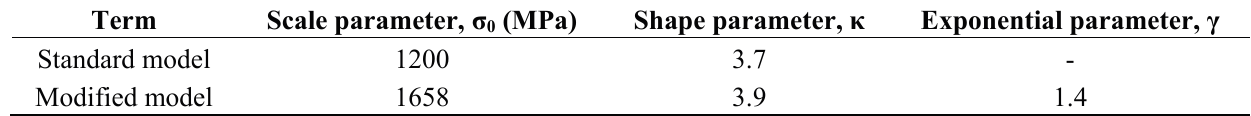
Table 3. Weak-link Weibull estimates for tensile strength in the fiber length direction.